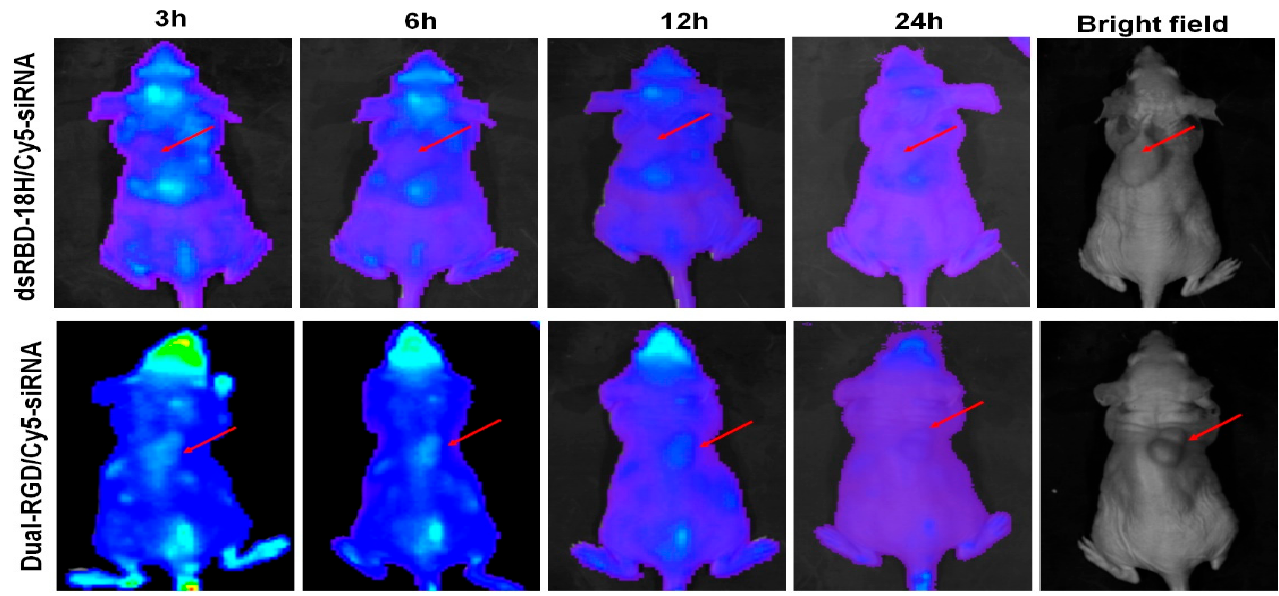
Figure 6. Time-course imaging of Cy5-siRNA/dual-RGD in vivo biodistribution. MDA-MB-231 tumor-bearing mice were iv-treated with complexes of Cy5-siRNA/dual-RGD or Cy5-siRNA/dsRBD-18His. Biodistribution was captured with Xenogen IVIS 100 system.